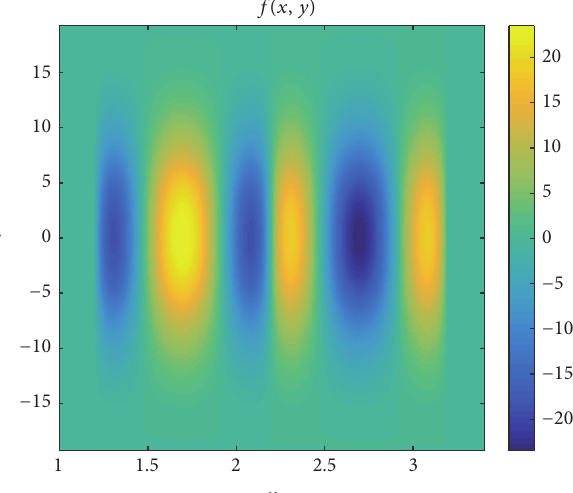
Figure 12: This is the source 𝑓 defined by (85)–(87) with the parameters 𝑑 0 = 1.2𝑎 and 𝑑 1 = 𝑑 0 + 2